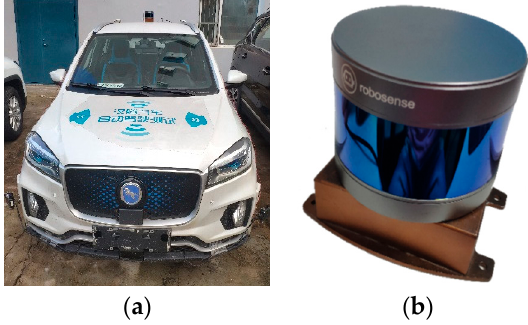
Figure 15. ( a ) Experimental platform; ( b ) LiDAR-IMU pair.